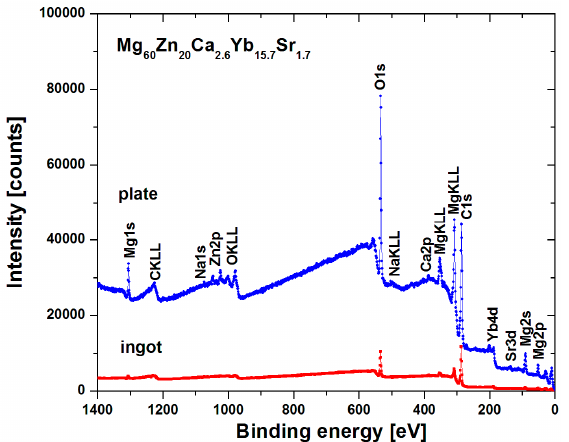
Figure 6. XPS survey spectra of Mg 60 Zn 20 Ca 2.6 Yb 15.7 Sr 1.7 alloy in a form of ingots and plates after corrosion tests in Ringer’s solution at 37 °C.